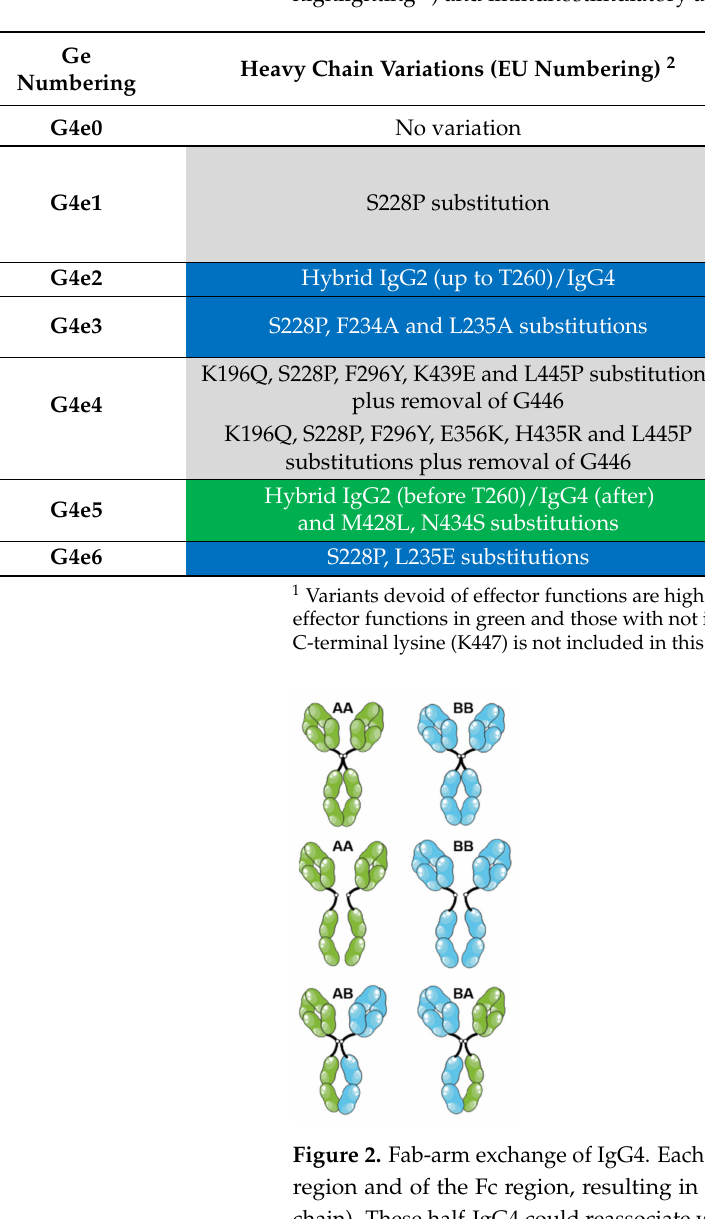
Table 2. Updated version of the nomenclature of G4e variants of IgG4, with a focus on silent (blue highlighting 1 ) and immunostimulatory antibodies highlighted in capital letters.